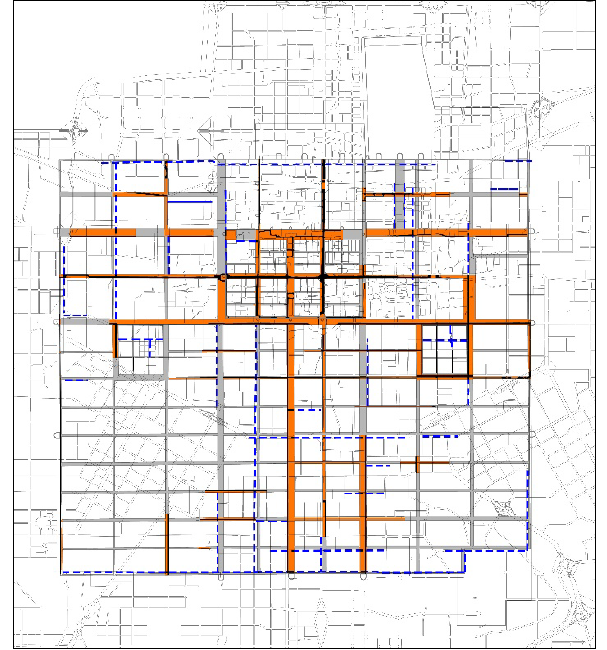
Figure 5. The Inheritance of the roads in modern Xi'an city from Chang'an City of Tang Dynasty